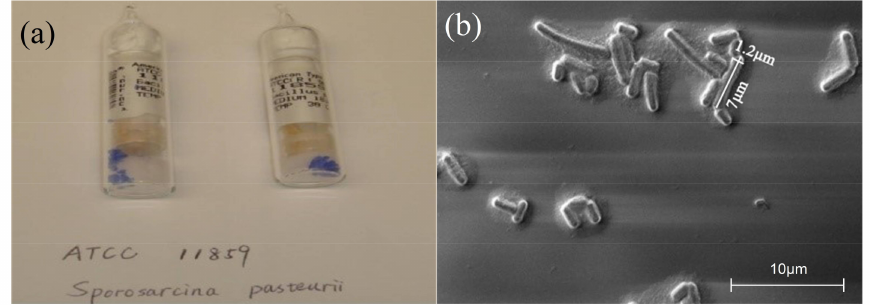
Figure 1. Sporosarcina pasteurii (ATCC 11859): ( a ) test strain; ( b ) SEM images of the bacteria.